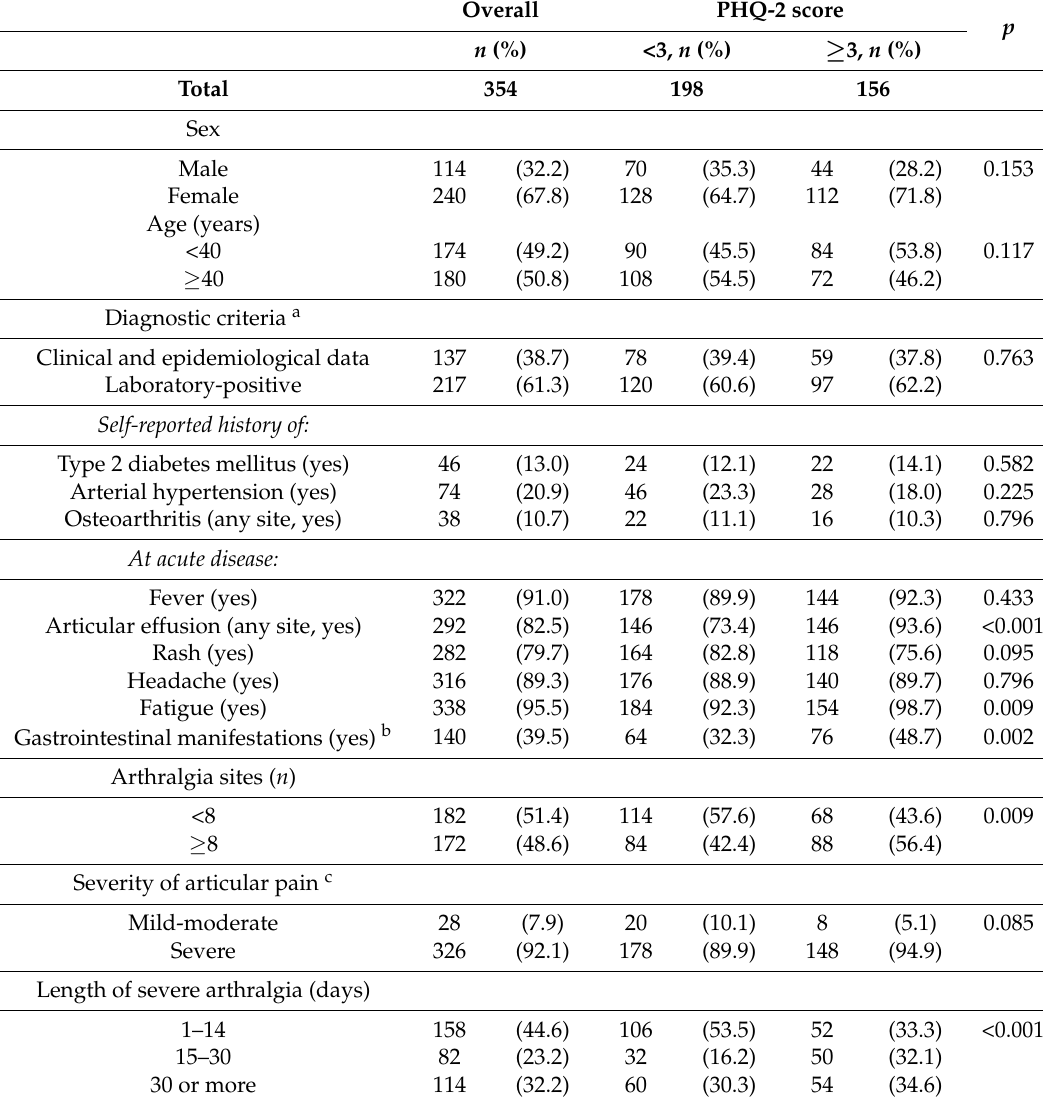
Table 1. Baseline characteristics of study sample and Patient Health Questionnaire-2 (PHQ-2) score during acute chikungunya virus infection, Mexico